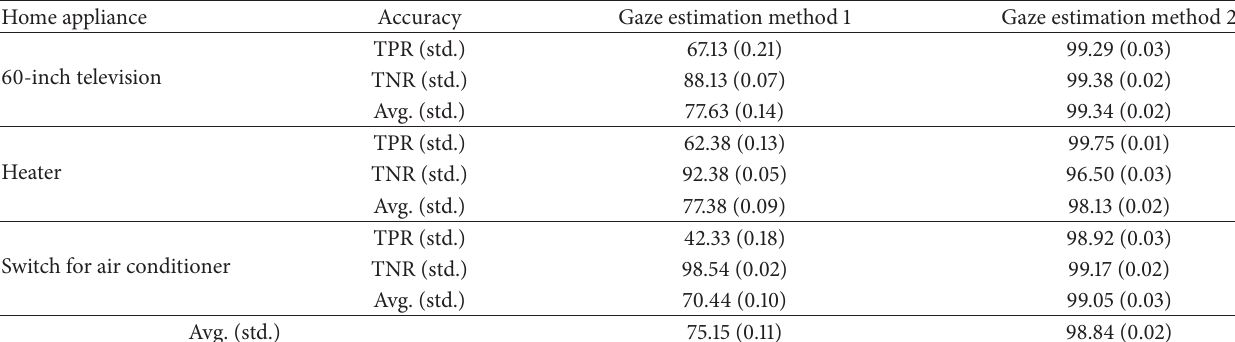
Table 3: TPR and TNR values (and standard deviation) of the three home appliances using gaze estimation methods 1 and 2 (%). Home